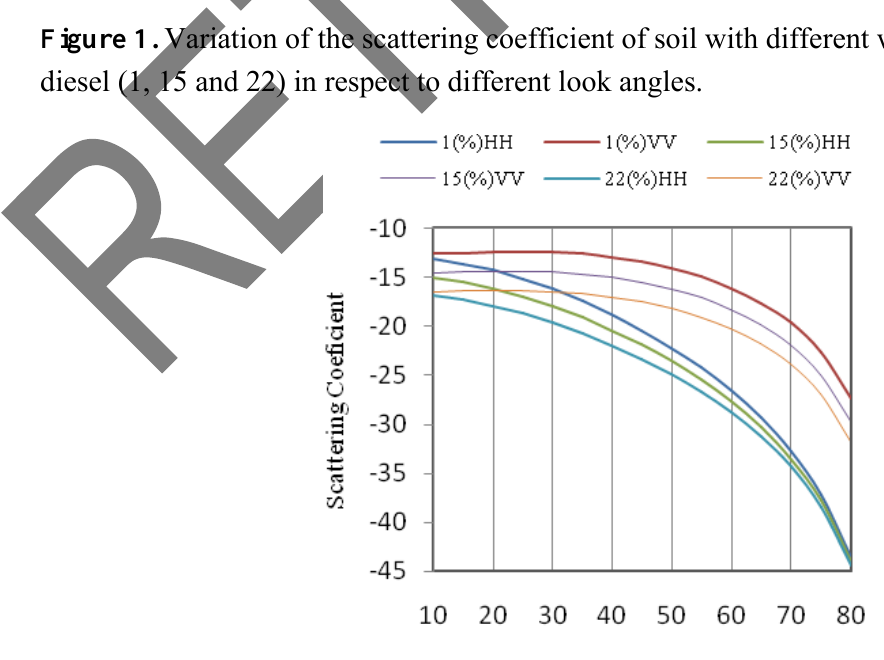
Figure 1. Variation of the scattering coefficient of soil with different weight percentages of diesel (1, 15 and 22) in respect to different look